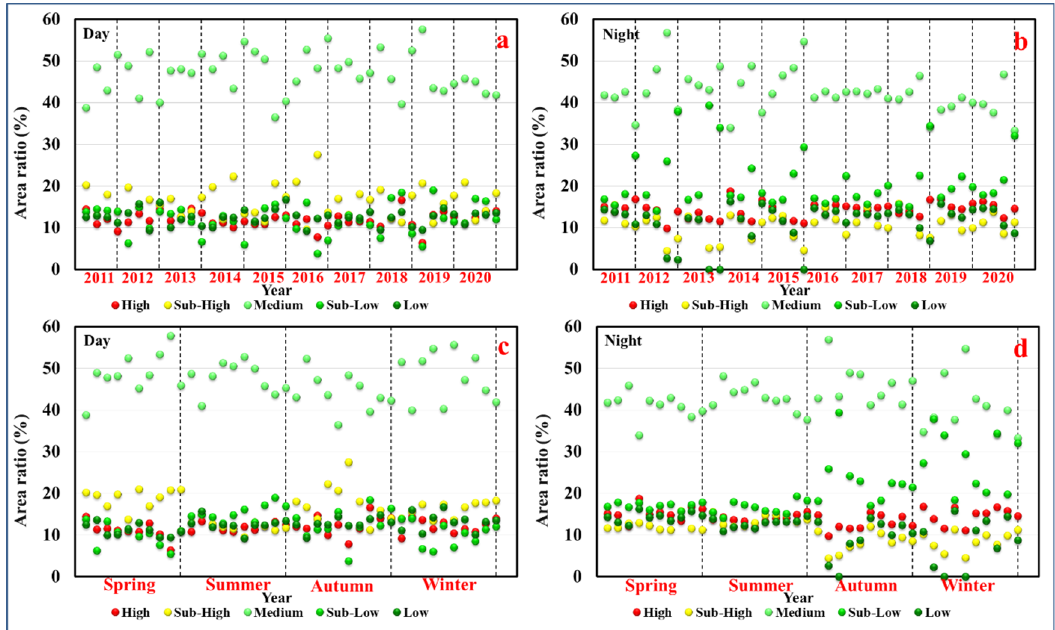
Figure 4. The area ratio of each temperature level zone from 2011 to 2020 (( a , b ) are the area ratios of temperature zones during daytime and nighttime in different years, respectively; ( c , d ) are the area ratios of temperature zones during daytime and nighttime in different seasons, respectively).